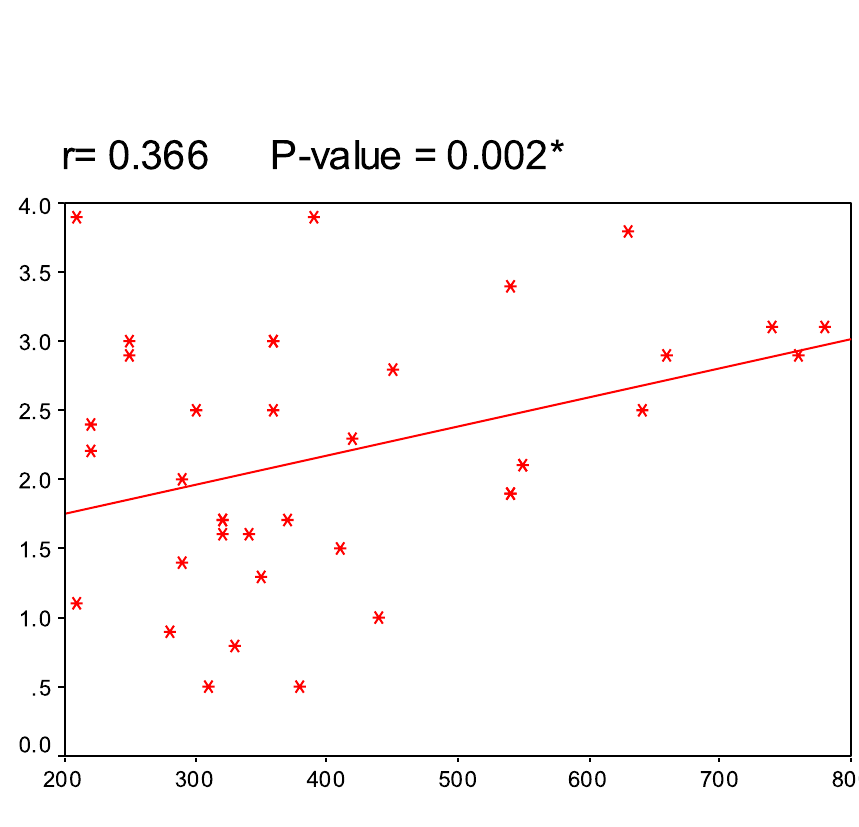
Fig. 3 Correlation between ASDAS and